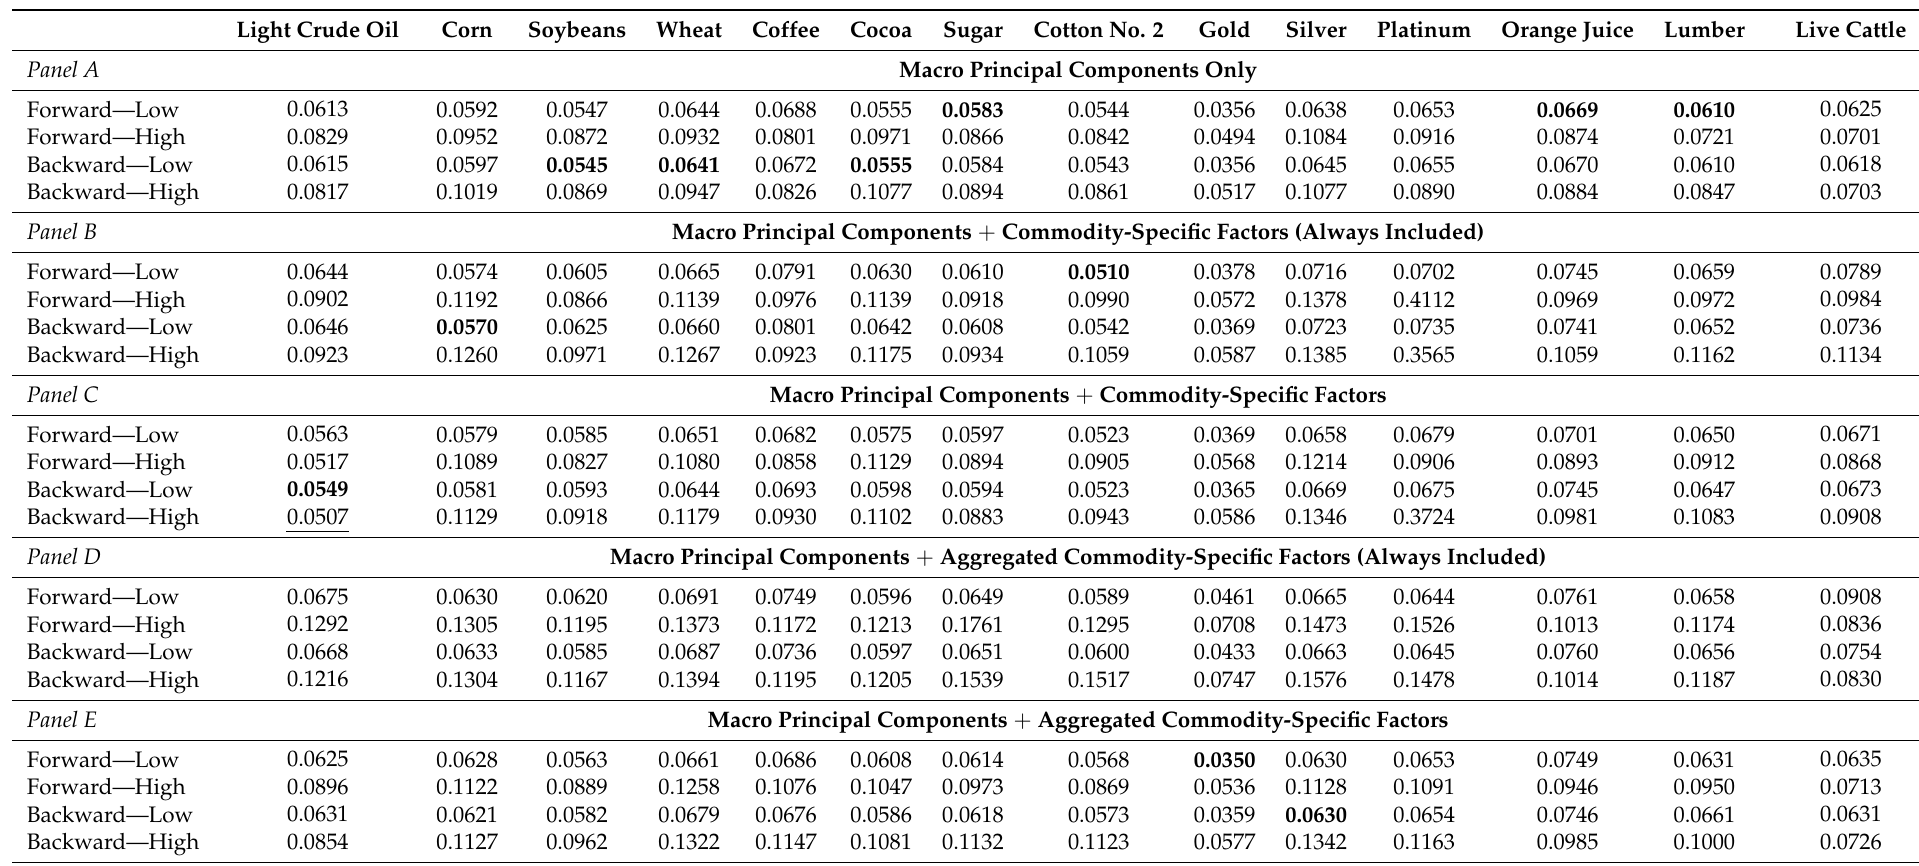
Table 3. The table displays root mean square error forecast performances—hidden Markov chain vs. stepwise regression models. The table reports the RMSFE implied by the forecasts obtained from the three HMM and the 12 stepwise (forward vs. backward) predictive regression models recursively implemented in our analysis. In particular, the table obtains the forecasts by weighting (over the entire OOS period, January 2004–May 2018) the regime-specific stepwise regression forecasts by the predicted regime probabilities obtained from a two-state HMM for the VIX index. In the different panels we have boldfaced the forecasting model that yields the minimum